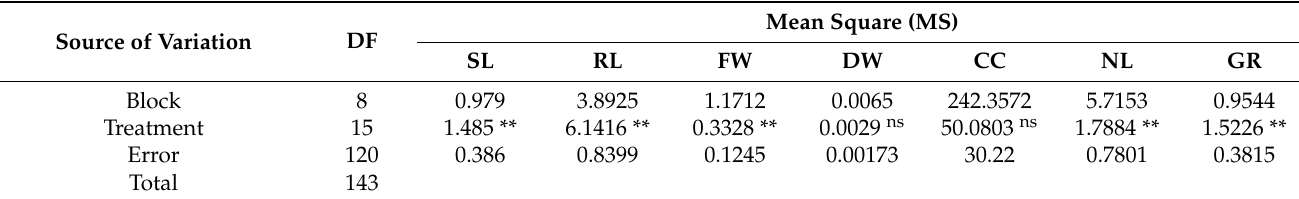
Table 2. Analysis of variance showing the statistical significance effect of various treatments on the growth parameters shoot length (SL), root length (RL), fresh weight (FW), dry weight (DW), spad index (CC), number of leaves (NL), and growth rate (GR) of seedlings. ** Indicates highly significant differences at 0.05 (5%) level, ns = not significant. Source of Variation DF